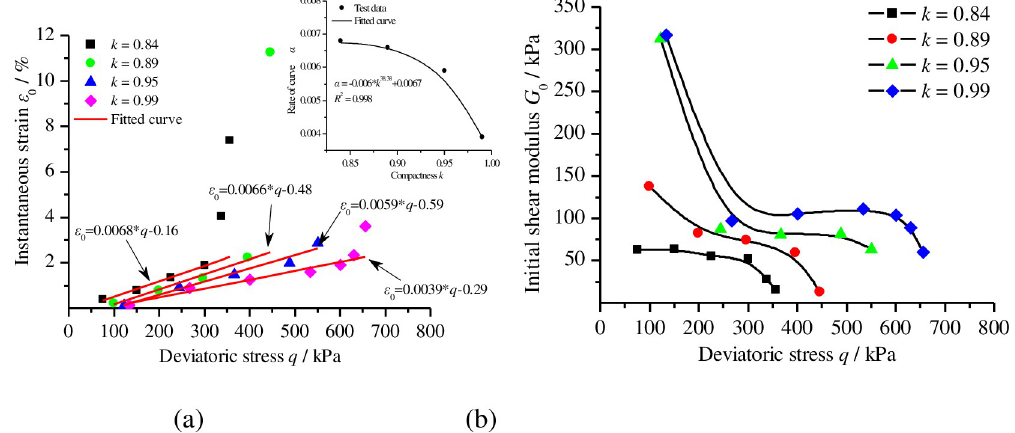
Fig 8. The relationship of instantaneous strain and initial shear modulus with deviatoric stress. (a) Instantaneous strain under different levels of compactness; (b) initial shear modulus under different levels of compactness.